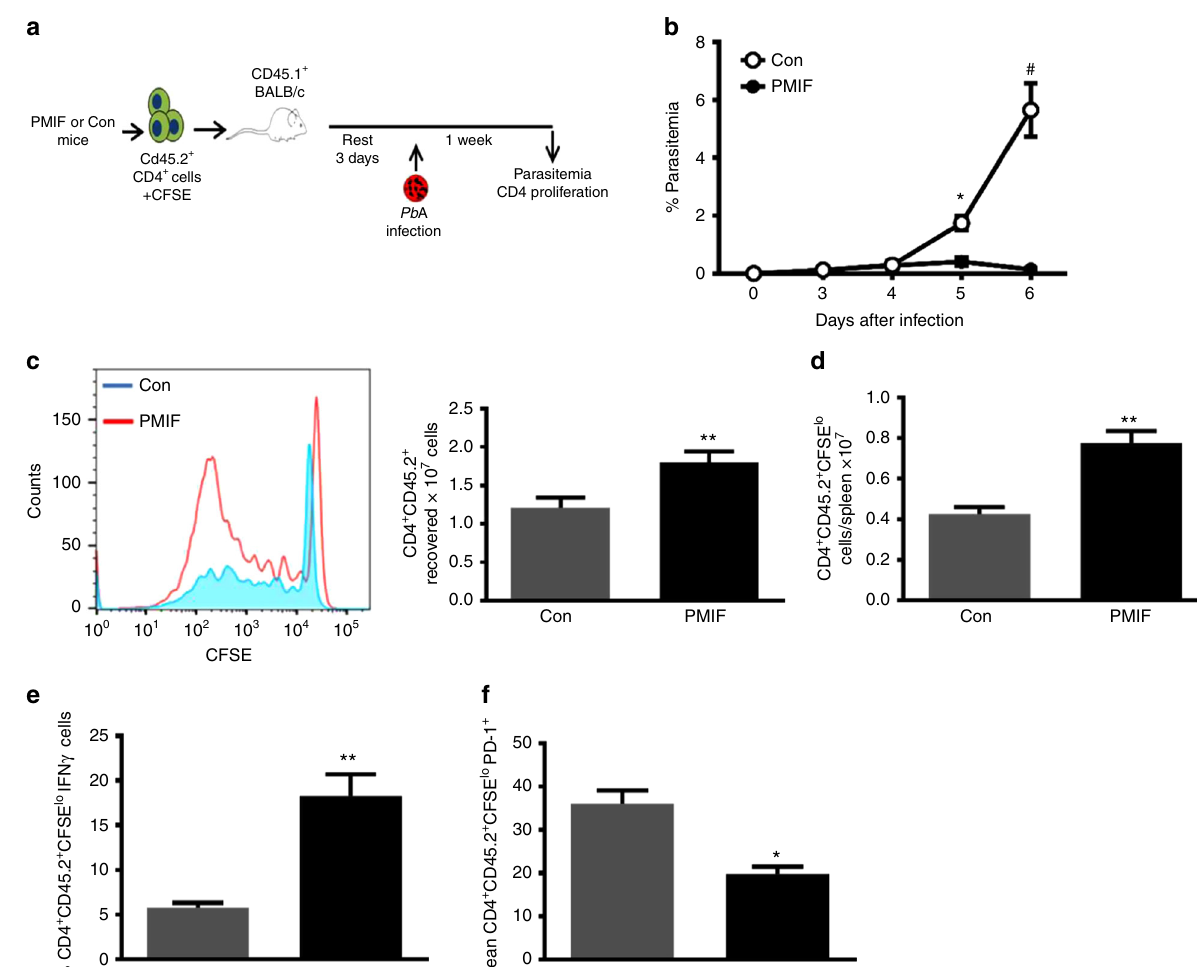
Fig. 7 Adoptively transferred CD4 T cells from PMIF-immunized mice confer protection to challenge by iRBCs. a BALB/cJ mice immunized with replicons encoding Con RNA or PMIF RNA were infected with 10 6 Pb AWT iRBCs and treated with chloroquine on days 7 – 12. Four weeks later, the mice were reinfected with 10 6 Pb AWT iRBCs and splenocytes isolated 7 days after infection, incubated with chloroquine to eliminate blood-stage parasites, and labeled with CFSE. Puri fi ed CD4 + CD45.2 + T cells (2 × 10 7 ) then were transferred into naïve congenic CD45.1 BALB/cJ hosts and the mice infected 3 days later with 10 6 Pb AWT iRBCs. b Frequency of iRBCs in mice adoptively transferred with CD4 T cells from Con (white circle) or PMIF (black circle) RNA immunized mice. Results are from two separate experiments. Bars represent the mean of 6 mice ± SD; * p < 0.05, # p < 0.001 by two-way ANOVA. c Representative CFSE dilution histogram of adoptively transferred CD4 + T cells (CD45.2) from donors immunized with Con or PMIF RNA and enumeration of recovered CD45.2 CD4 + T cells, and d proliferative response of transferred CD4 T cells into CD45.1 recipients 7 days after infection. e Percentage of proliferating CD45.2 + CD4 + T cells (CFSE lo ) producing IFN- γ after stimulation ex vivo with iRBC lysates in the presence of Brefeldin A. f Mean fl uorescence intensity of PD-1 in Pb AWT responsive CD45.2 + CD4 + T cells (CFSE lo ) from Con or PMIF RNA immunized donors. Results are from two separate experiments. Bars represent the mean of 8 mice ± SD; * p < 0.05, ** p < 0.01 by two-tailed Mann – Whitney